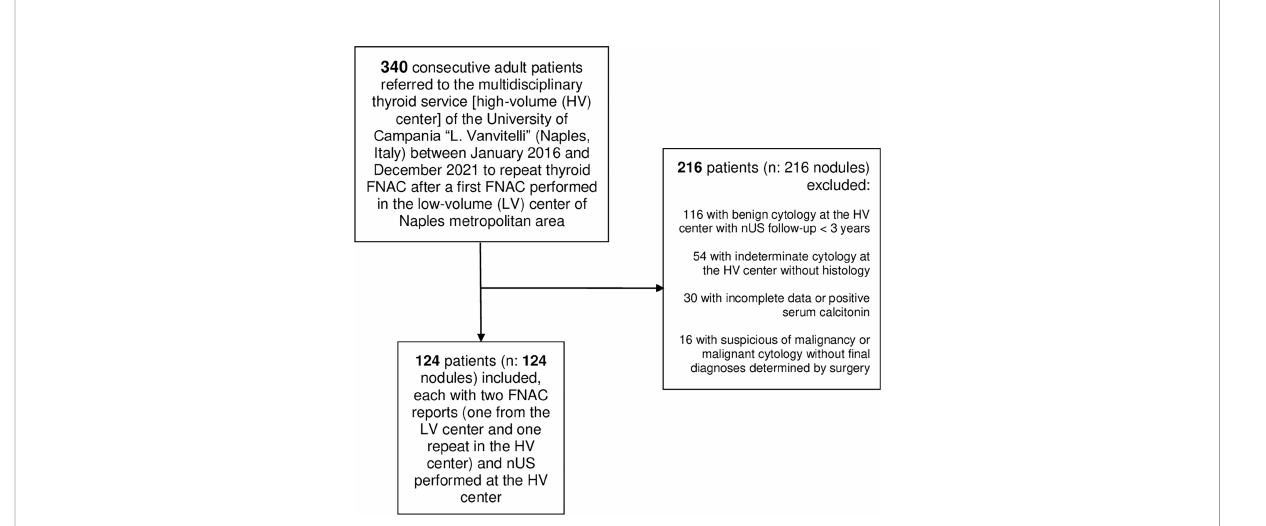
FIGURE 1 Flowchart of patients ’ selection nUS, neck ultrasound; FNAC, fi ne needle aspiration